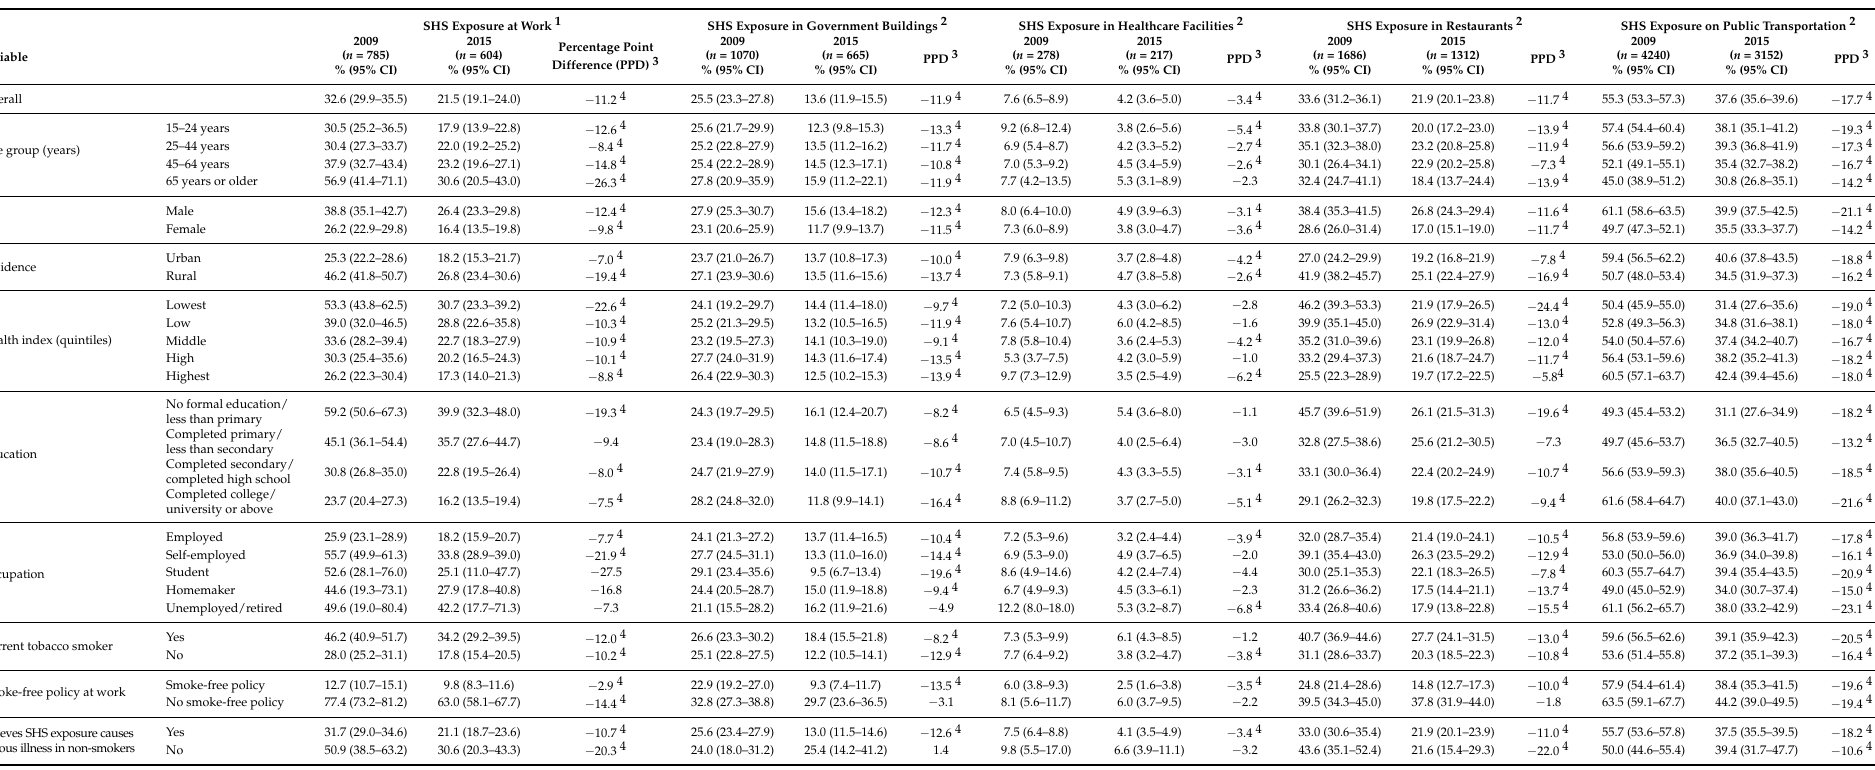
Table 2. Prevalence of SHS exposure by sociodemographic characteristics, tobacco use, and smoking policies among adults aged 15 years or older in the